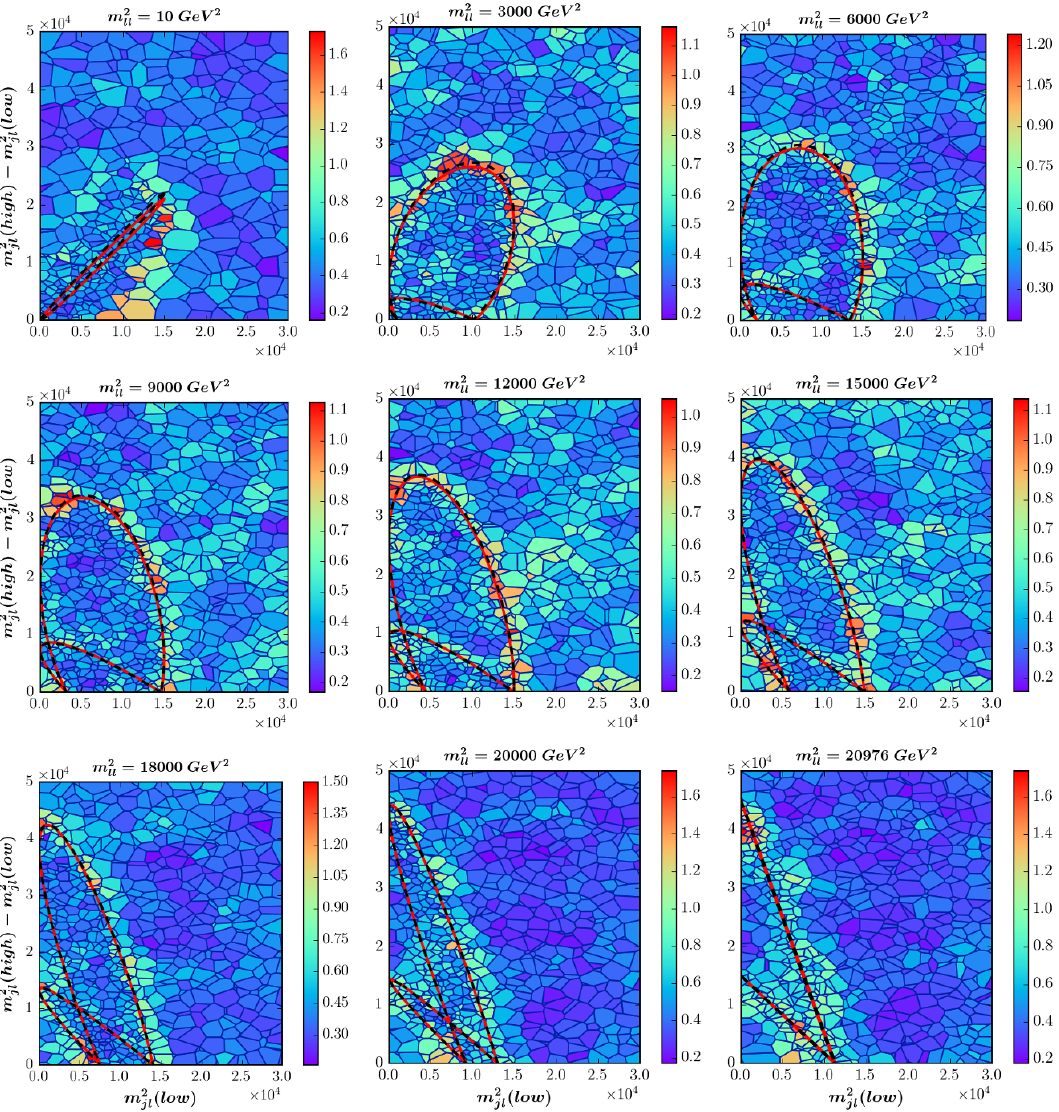
Figure 12 . Two-dimensional views at (cid:12)xed m 2 of the Voronoi tessellation of the data for the case ‘‘ of S=B = 3. The red solid line is the expected signal boundary for the nominal case of point P 31 , i.e., with the true value ~ m A = m A = 236 : 6 GeV. The black dashed line corresponds to the mass spectrum with ~ m A = 280 GeV, which was found to maximize the quantity (cid:22)(cid:6) in the top left panel of (cid:12)gure